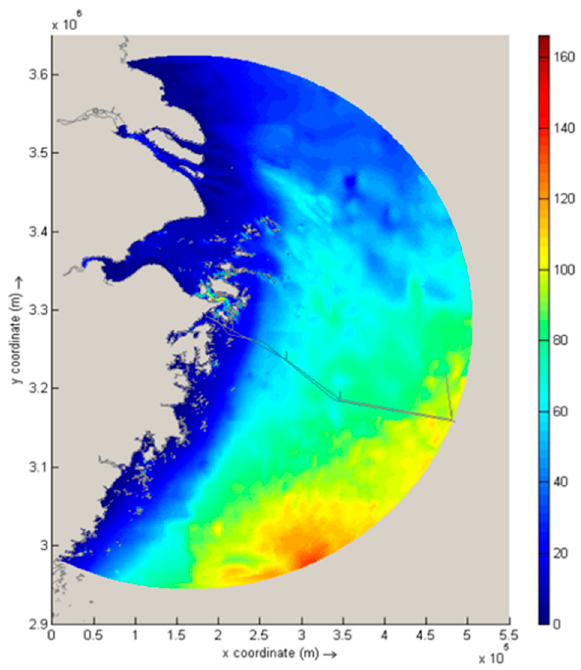
Figure 3. Sea topography and coastline.